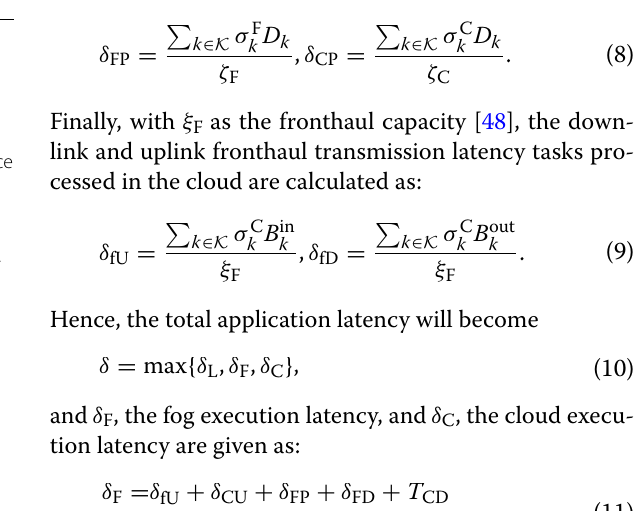
Table 2 Summary of Notations